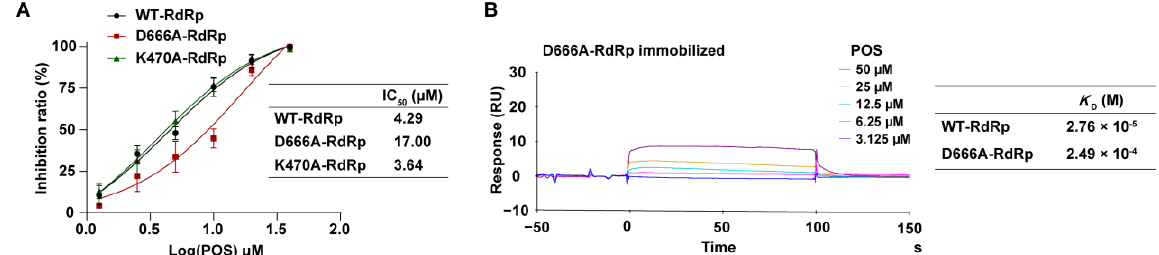
Figure 4. The mechanism of the inhibitory effect for POS. ( A ) The inhibitory effect of POS (1.25 – 40 μM) on RdRp, D666A-RdRp and K470A-RdRp. IC 50 s are plotted as the inhibition ratio of the fluorescence intensity over the concentration of compounds. The IC 50 s of POS for WT-RdRp, D666A-RdRp and K470A-RdRp were 4.29 μM, 17.00 μM and 3.64 μM, respectively. ( B ) The affinity analysis between POS (3.125 – 50 μM ) and D666A-RdRp by SPR. The K D of POS on D666A-RdRp was 2.49 × 10 −4 M, which was 10-fold higher than that on WT-RdRp (2.76 × 10 −5 M).